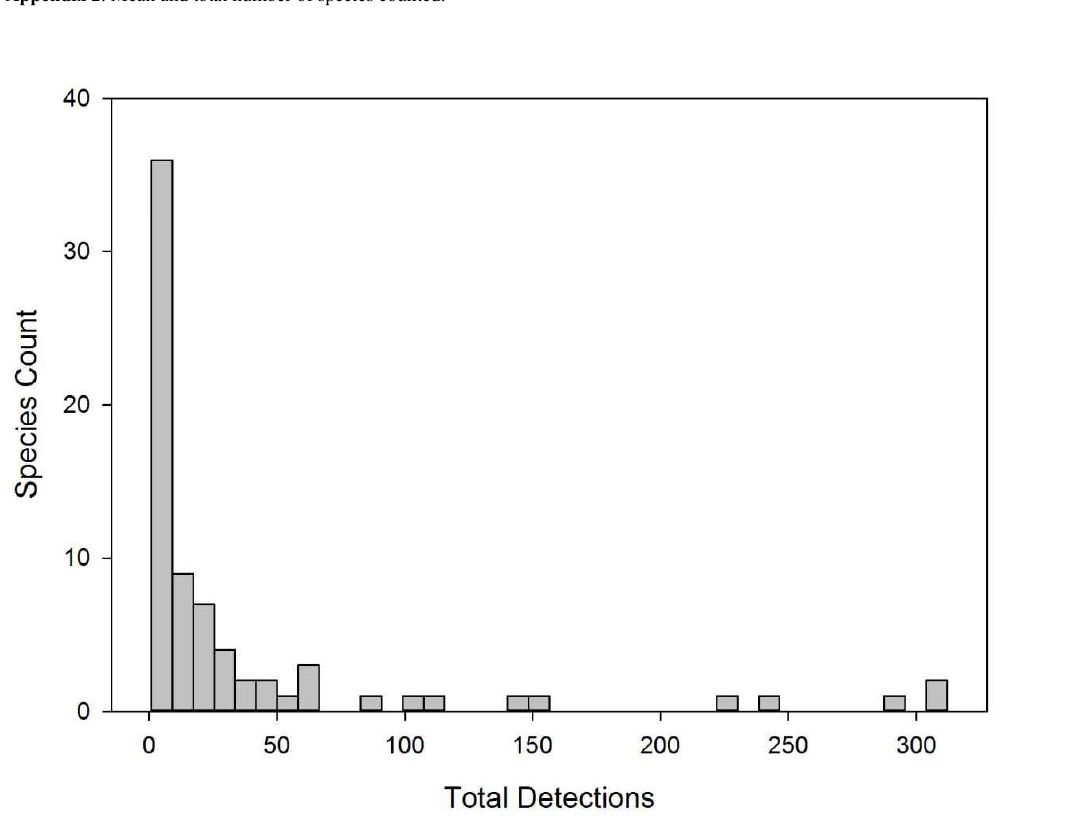
Figure A2.1. Distribution of the total number of individuals detected for each species irrespective of treatment and land cover type. A total of 351 individual birds from 76 species were detected in this